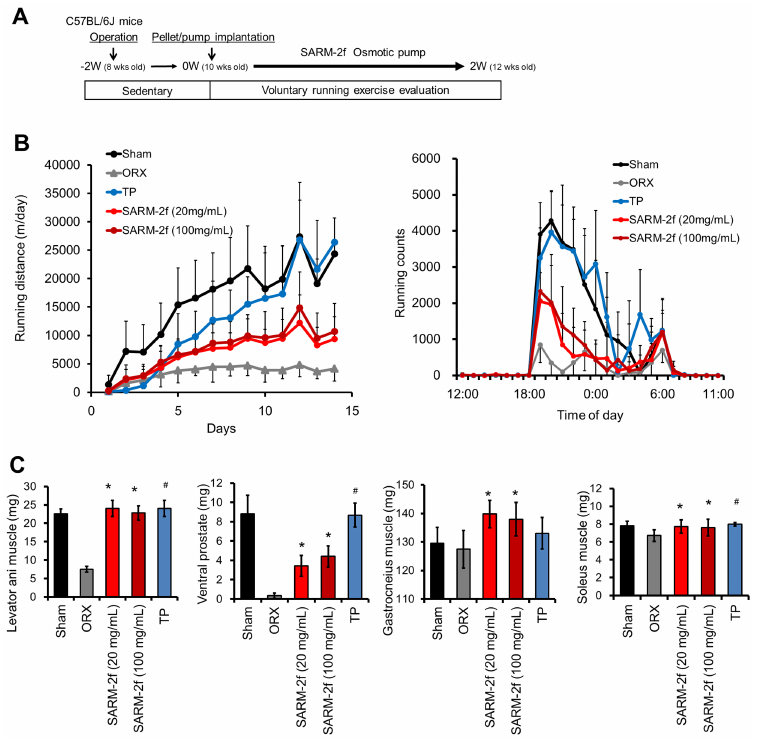
Fig 6. Effects of SARM-2f on mouse voluntary running. The outline of the voluntary runningtest is shown in Fig 6A. Runningdistanceduring2 weeks of treatment with TP or SARM-2f was calculatedby the formula describedin the Materialsand methods section (B). (B) Runningcount averagein day13–14.(C) Levator ani muscle weight measuredafter 2-week dosing.The drug was administered to castrated mice with DHEA for 2 weeks. The measurement techniqueis describedin the Materials and methods section. Data are shown as the means ± SD (n = 8). * P < 0.025 vs. the ORX (vehicle treated castrated mice) group using the Williams test. #P < 0.05 vs the ORX by student